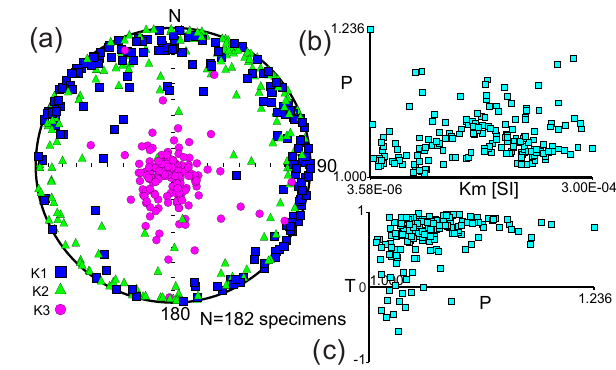
Figure 15. Preliminary anisotropy of magnetic susceptibility (AMS) data from Moenkopi Formation rocks intersected in CPCP Phase 1 Core 2B. (a) The stereographic projection shows the principal susceptibility axes ( K 1 ,K 2 ,K 3 = K max ,K int ,K min ) for each specimen measured (lower hemisphere projections). (b) The anisotropy parameter P , where P = K max /K min , is plotted vs. bulk susceptibility for each specimen measured. (c) The anisotropy pa- rameter T , where T , the shape parameter ( = ( [ 2ln K int − ln K max − ln K min ] / [ ln K max − ln K min ] ) is plotted vs. P . T values close to 1.0 are associated with strong oblate fabrics. In (a) the data from most Moenkopi rocks show a fabric that is typical of very fine-grained detrital sedimentary rocks, with the minimum susceptibility axis es- sentially vertical and overall well grouped. The principal suscepti- bility axes are plotted assuming that all sampled core segments are properly oriented; as discussed in the text this assumption is likely not always valid and thus improper core orientation may be a source of some of the observed dispersion in the data. An additional source of dispersion is that some Moenkopi facies may have preserved a well-defined sedimentary imbrication fabric, where the minimum susceptibility axis is canted from the